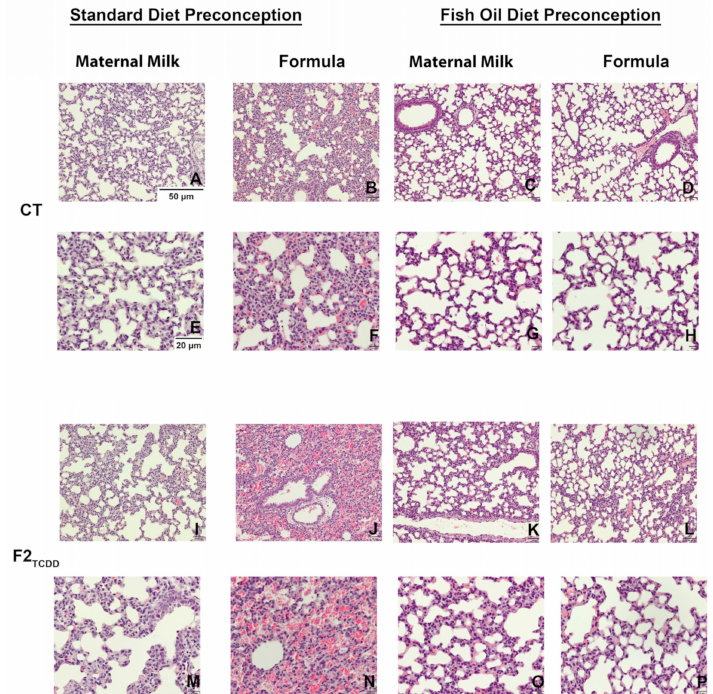
Figure 2. A paternal dietary fish oil intervention improves lung development in pups: Representative images of Hematoxylin- and Eosin-stained perfused lung tissue of PND11 CT pups sired by a standard or fish oil diet father following a maternal milk diet or supplemental formula at a magnification of 100 × ( A – D ) and 400 × ( E – H ); F2TCDD pups sired by a standard or fish oil diet father following a maternal milk diet or formula supplementation at a magnification of 100 × ( I – L ) and 400 × ( M – P